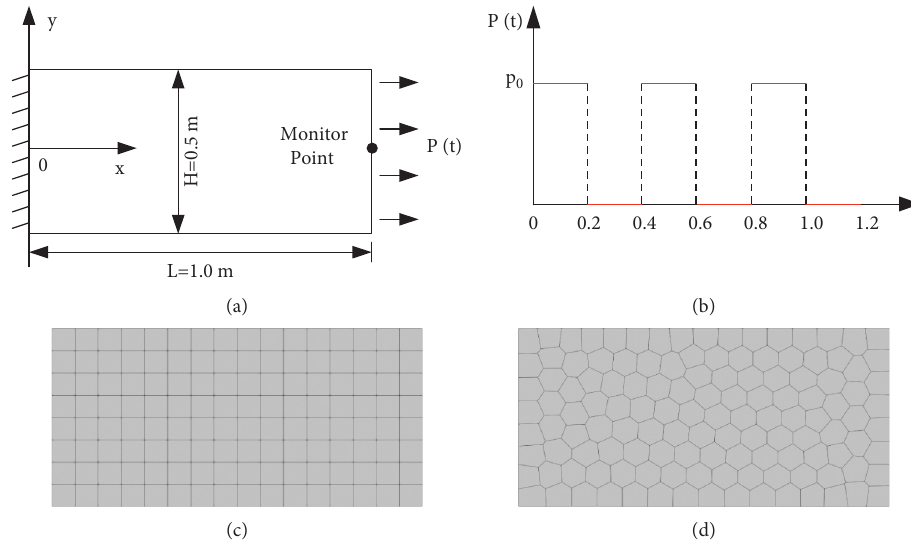
Figure 10: Heaviside step loading applied to a cantilever beam: (a) geometry and boundary condition, (b) Heaviside step loading, (c) Abaqus CPS4 element, and (d) PSBFEM